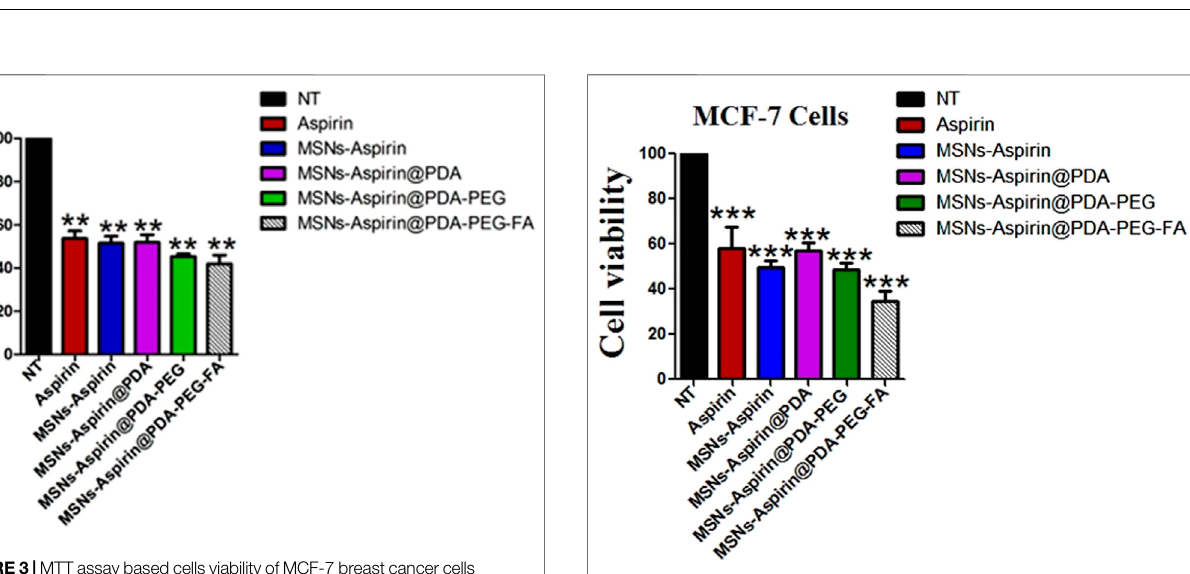
FIGURE 2 | The spectra for in vitro drug release through MNP-Asp@PD-PG-F with different pH media. (A) The pH value 7.4, (B) 5.6, and (C) 2.0.3.3.